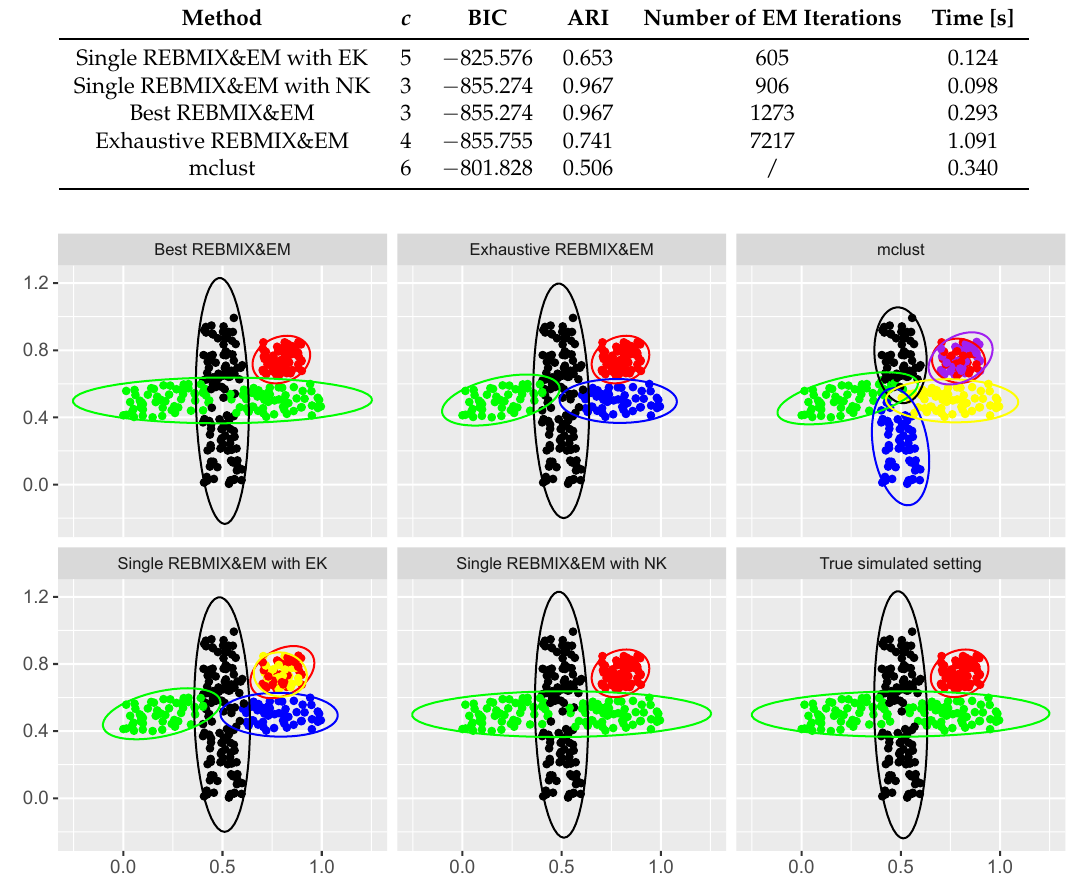
Figure 10. Solutions obtained with different methods used and the true clustering solution on a high overlapping clustering